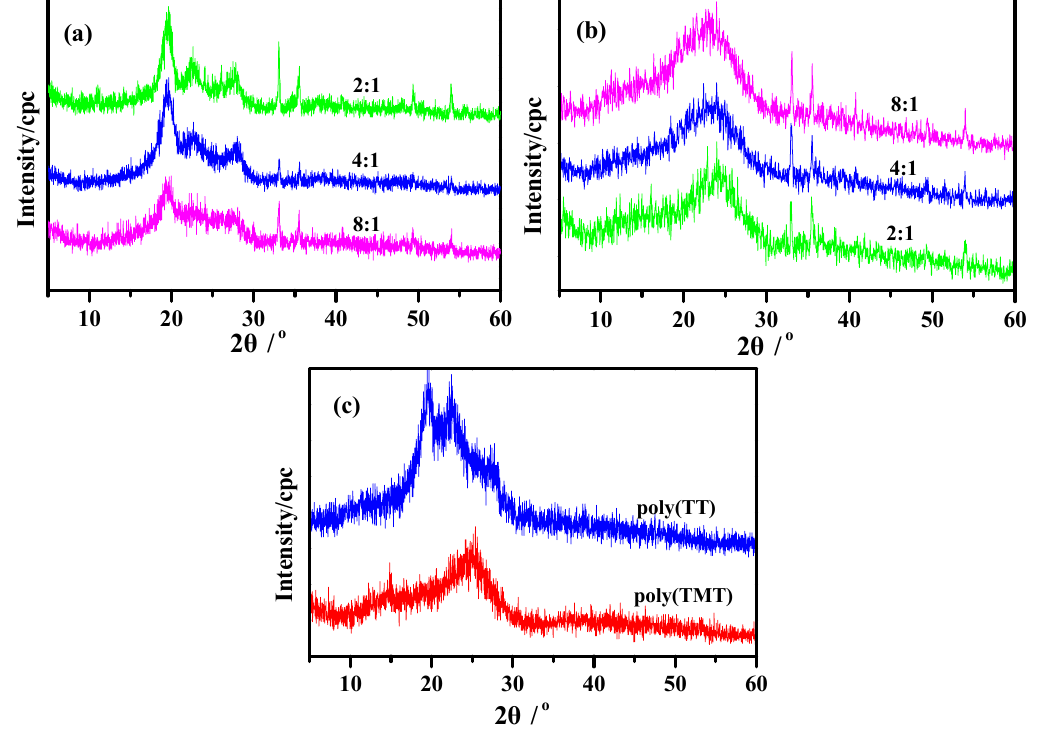
]/[monomer] ratio: 3